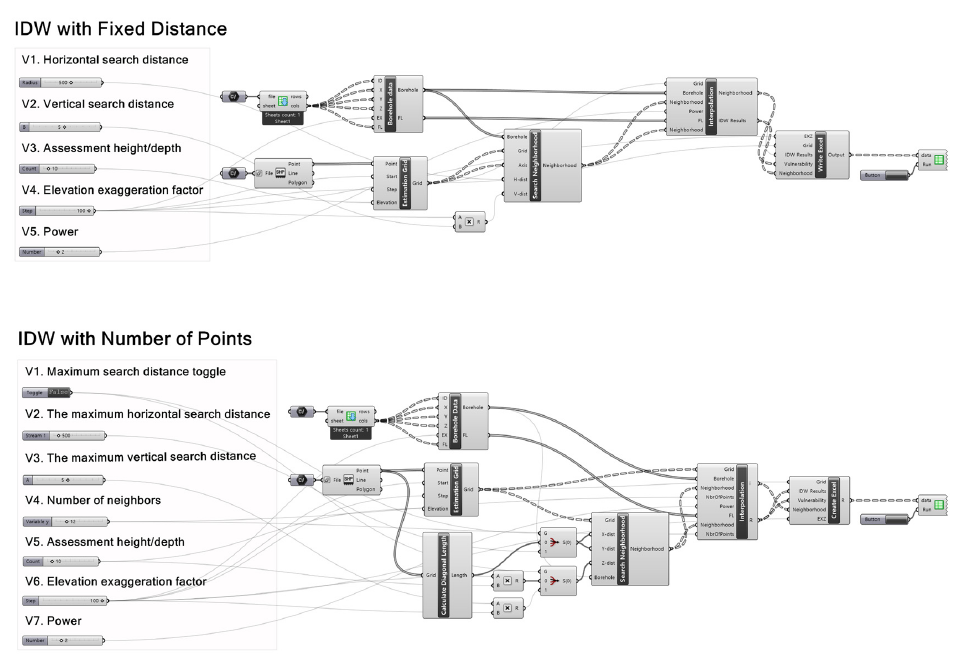
Figure 8. Limiting neighborhoods used for improved IDW: ( a ) Fixed search radius; ( b ) Fixed neigh ‐ borhood counts.